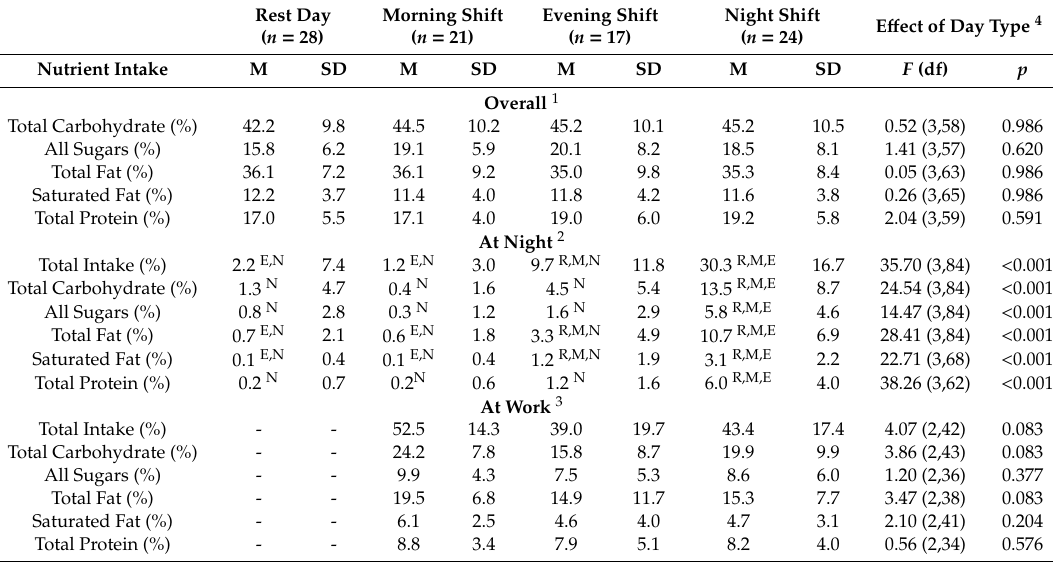
Table 3. Percentages of total caloric intake per day type at night and at work. Rest Day ( n =